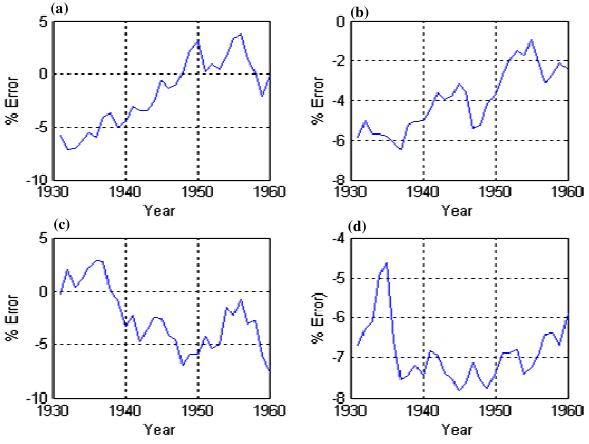
Fig. (13). Error Distribution after Regularization for (a) October (b) April (c) May (d) July.